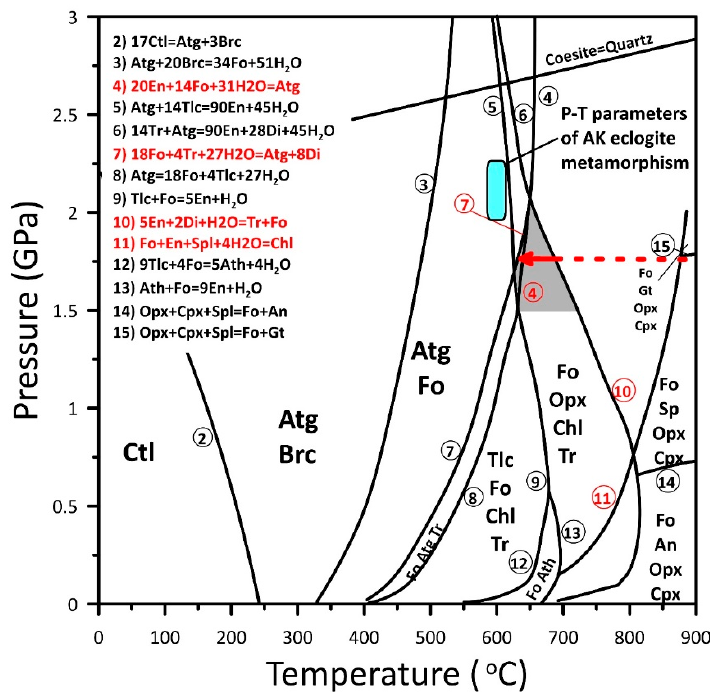
Figure 13. P–T conditions of metamorphism of the Alag Khadny peridotites, diagram after [75]. The gray area represents stability field of metamorphic mineral association of Alag Khadny peridotites. The red arrow indicates inferred P–T path of peridotites metamorphism. P–T parameters of peak metamorphism of Alag Khadny eclogite are from [22].